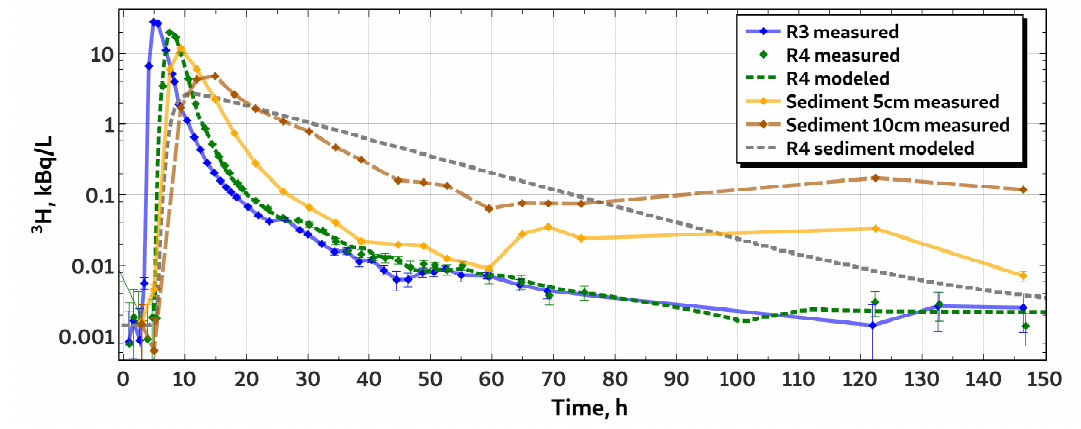
Figure 5. The 3 H activity concentrations observed at R3 and R4, and modeled at R4.